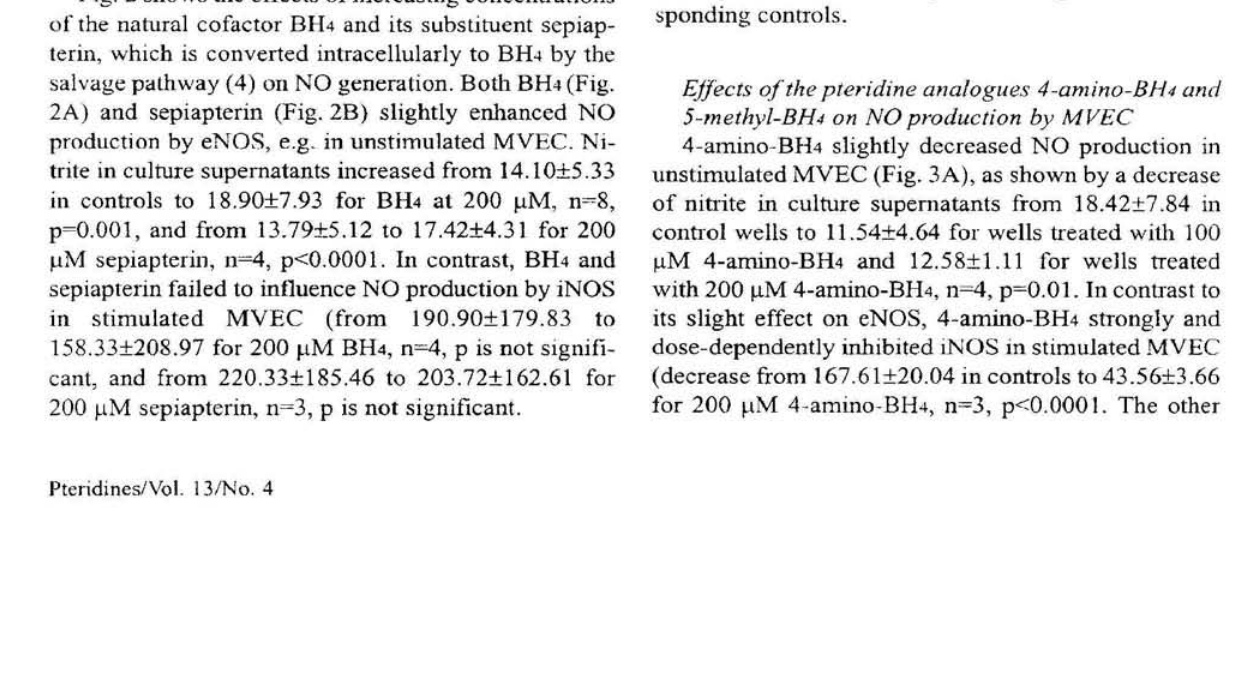
Figure 2. Effects of the natural cofactor BH4 and its substituent sepiapterin on NO production by MVEC. After achievement of confluence, MVEC were incu- bated without stimulus (open symbols) or treated with IFN-γ (100 U ml·') and LPS (10 μg ml· 1 ), and either BH4 (A) or sepiapterin (B) was added at the indicated concentrations. NO production was measured as nitrite in culture supernatants after 48 hours in triplicate wells and duplicate measurements. Results are presented as % change+SD from corresponding control wells. * denotes p<0.01 as compared to corresponding wells treated with L-NAME 10 μΜ or 25 μΜ and p<0.05 as compared to 50 μΜ. ** p<0.01 compared to corre- sponding